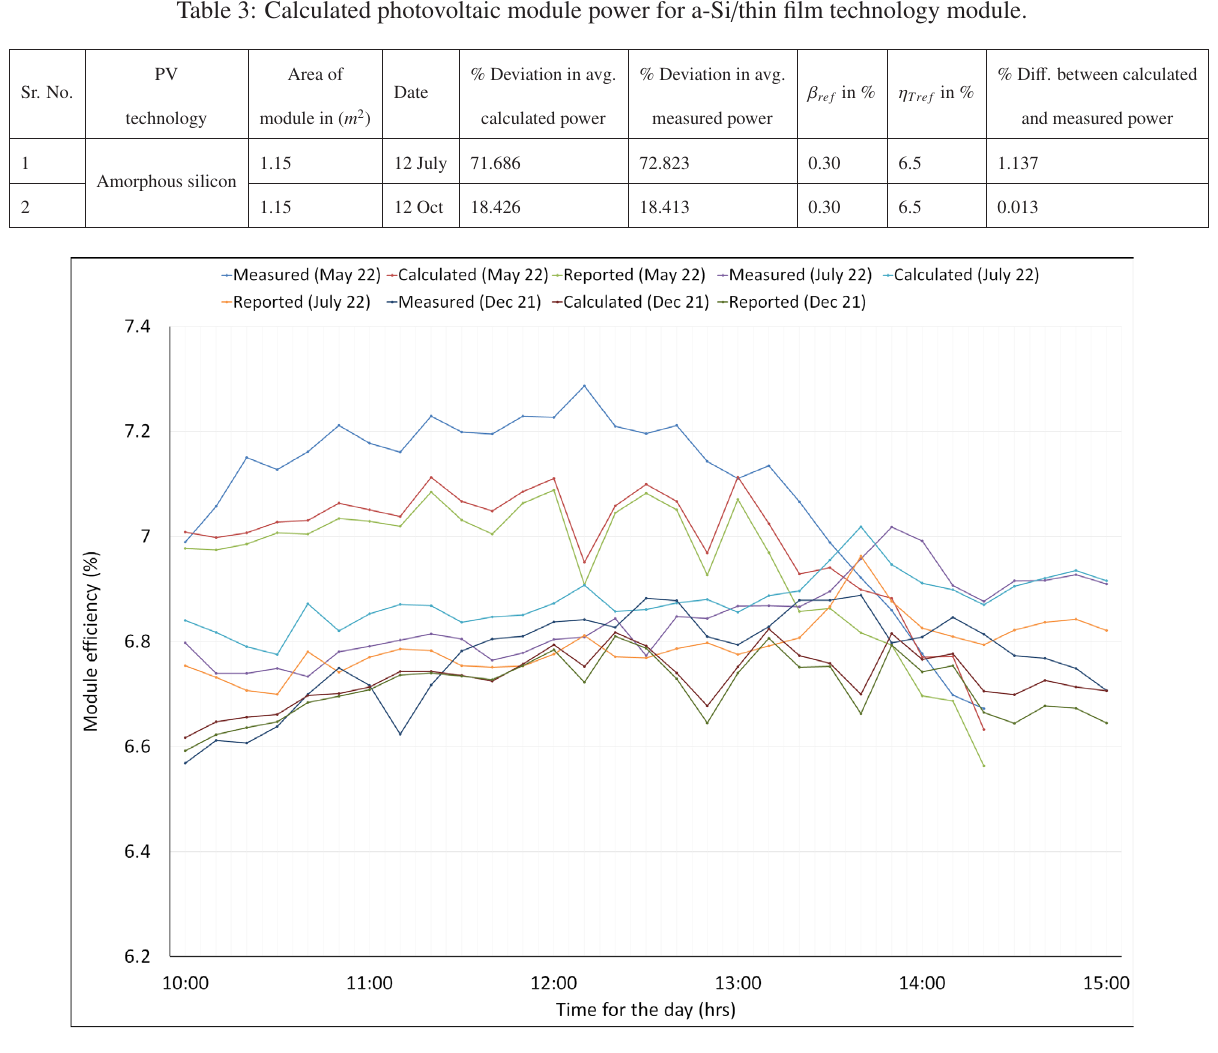
Figure 8. Seasonal module e ffi ciency variation for Amorphous-Silicon PV